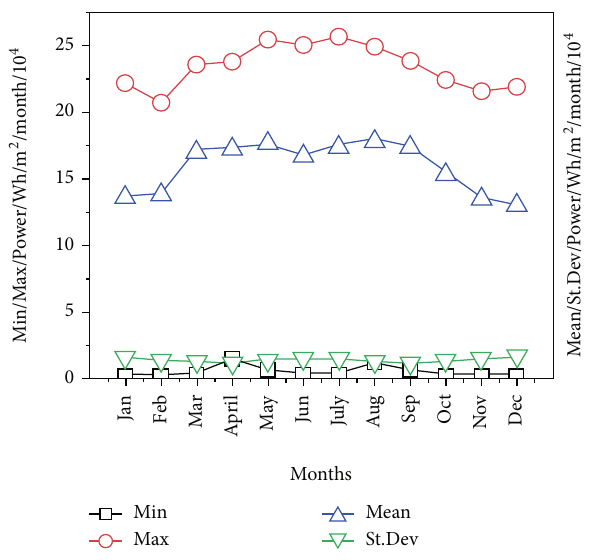
Figure 7: Monthly global solar Table 2: Temporal monthly radiation in Ethiopia (Wh/m 2 / month).